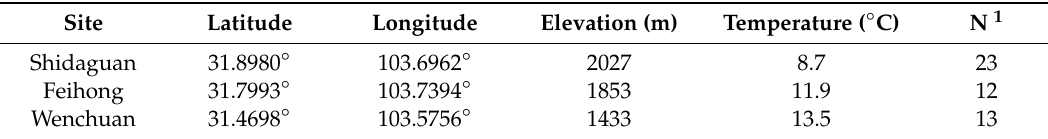
1 N: number of sampling plots.